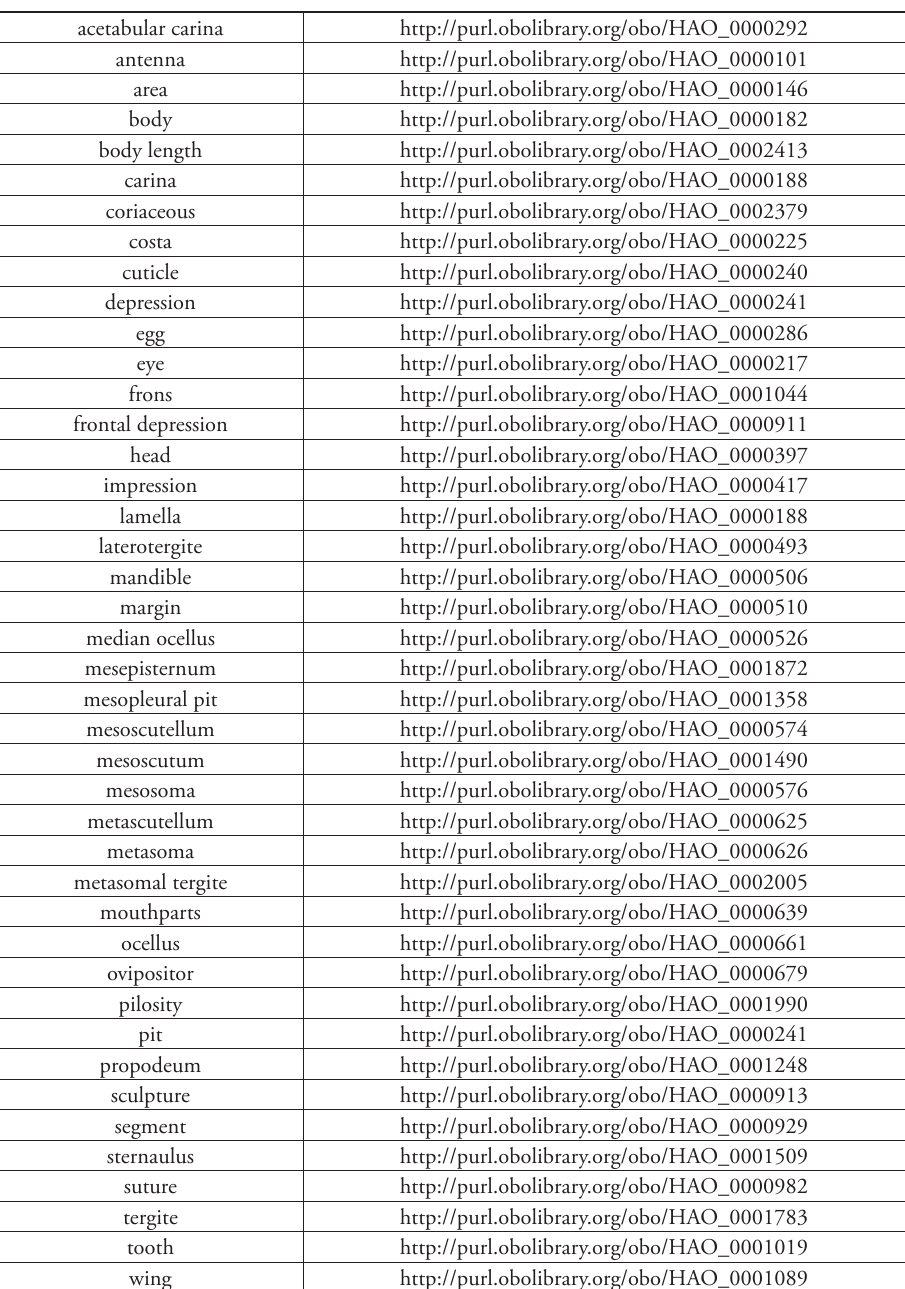
URI Table matching terms and concepts used in this revision with the Hymenoptera Anatomy Ontology